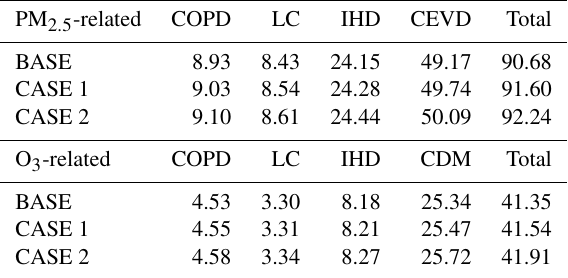
Table 1. Annual premature deaths ( × 10 4 deaths) in China due to COPD, LC, IHD, CDM and CEVD for all